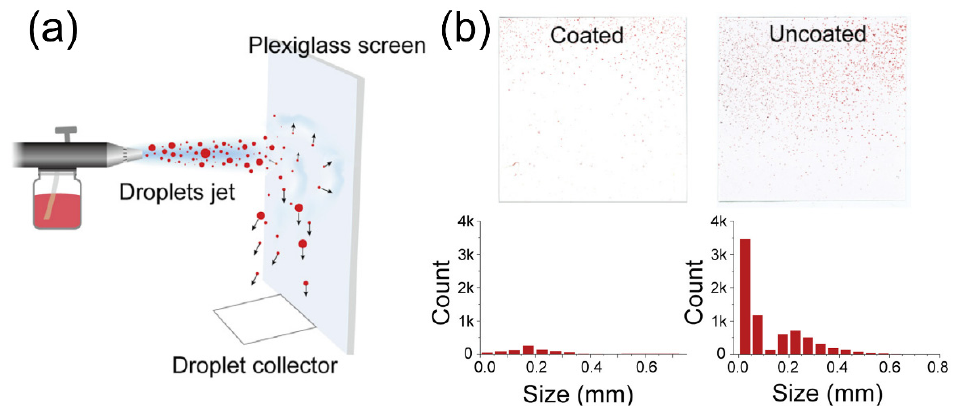
Figure 3. Nanostructured coating for COVID-19 treatment and prevention. ( a ) Schematic illustration of spray experiment for accessing the treatment performance. ( b ) Photos and corresponding histograms showing the droplet marks and their size distributions, respectively. Reprinted from [75], with permission from Elsevier Inc.